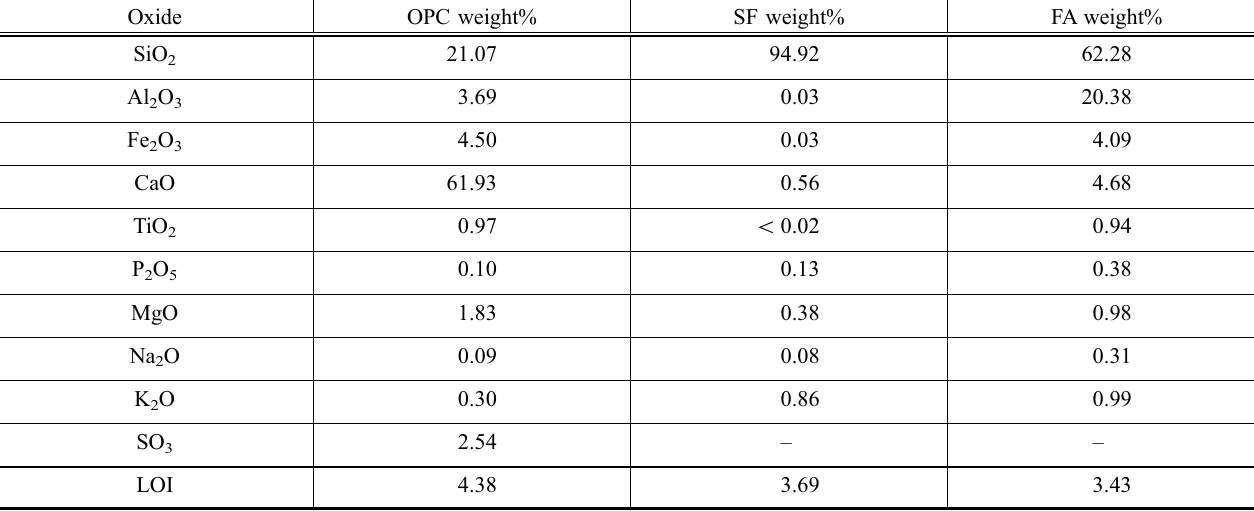
Table 1 Oxide analysis of the Portland cement and mineral admixtures